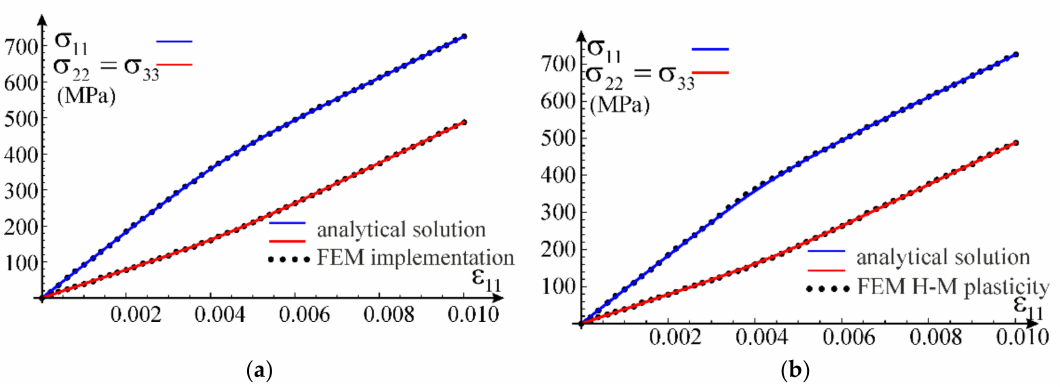
Figure 9. Comparison of the analytic elastic solution for the uniaxial strain test with: ( a ) FEM solution according to our own implementation, ( b ) FEM solution based on the standard elastic-plastic